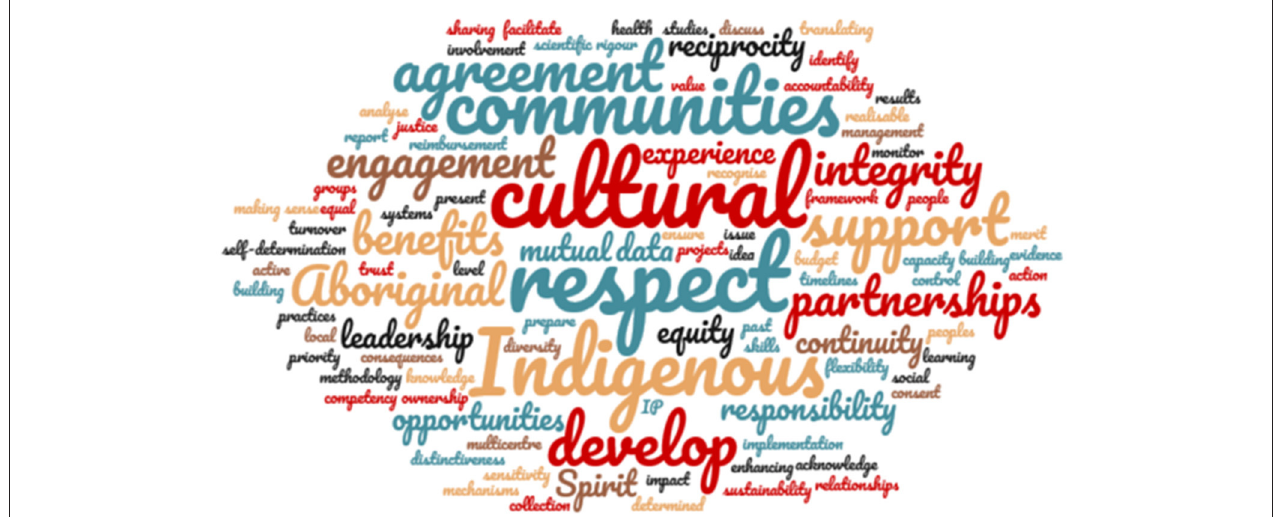
FIGURE 2 | A word cloud summary of the principles and core values of the ethical guidelines relevant to the study of native Australian plants. The guidelines used were AIATSIS Code of Ethics for Aboriginal and Torres Strait Islander Research ( 67), the National Statement on Ethical Conduct in Human Research section 4.7 (28), Ethical conduct in research with Aboriginal and Torres Strait Islander Peoples and communities: Guidelines for researchers and stakeholders (70), Keeping Research on Track II ( 69), the AH&MRC Guidelines for Research into Aboriginal Health: Key Principles (71) and Ten principles relevant to health research among Indigenous Australian populations ( 72). The more frequently a key word is used in the respective text, the larger in size it is presented. This word cloud was made using WordClouds.com (Zygomatic).